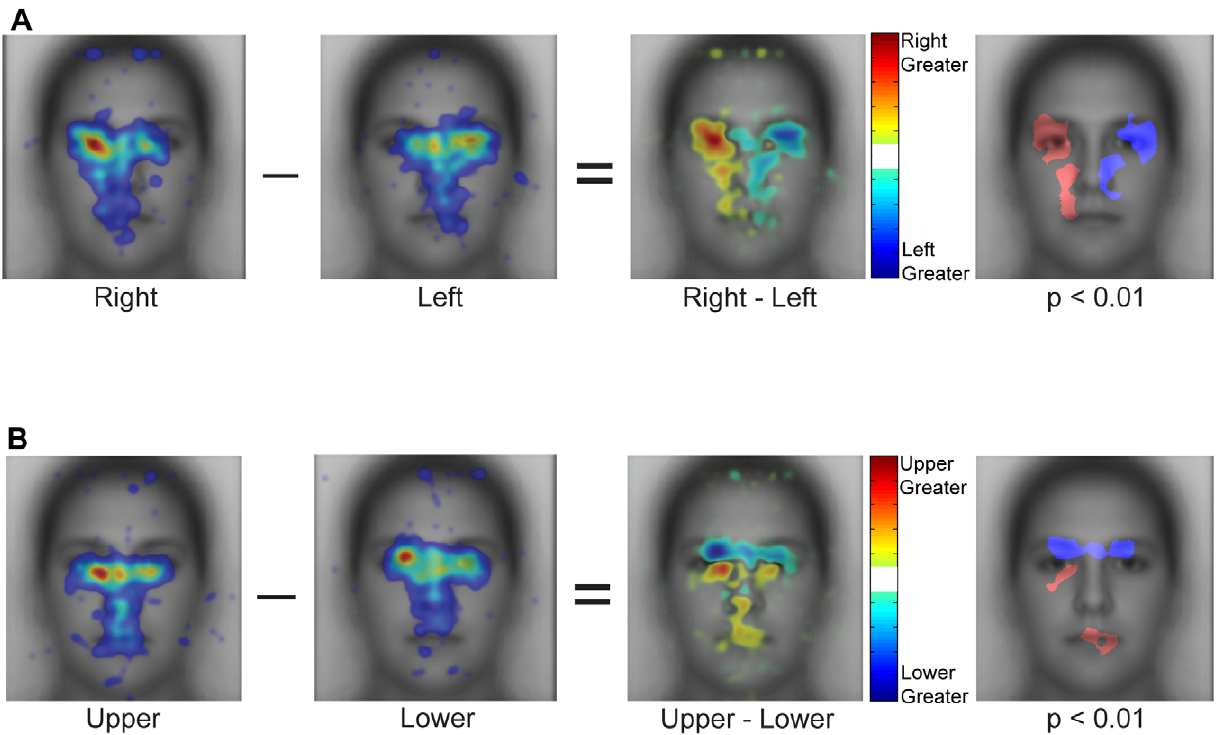
Figure 7. Direct comparison of spatial distributions of fixations for different start positions on upright faces. ( a ) Right vs. left start position. The first two panels are the raw spatial density maps for fixations 2–5. The third panel shows the subtraction of these spatial density maps. The fourth panel plots those locations where that difference was significant (p , 0.01) according to a Monte Carlo permutation test, which assumed exchangeability of fixations across contrasted start positions for each ordinal fixation. The map was cluster corrected (cluster threshold p , 0.05, see methods). Note the significant advantage for the side of the face opposite the start position. ( b ) Same as (a) but for the upper and lower start positions. Note again the strong and significant advantage for the side of the face opposite the start position. Fixation density in the raw heatmaps is indicated using a colorscale from zero to the maximum density value observed across the heatmaps for start position, with zero being transparent. The difference in fixation density in contrast heatmaps is indicated using a colorscale from plus to minus the largest absolute difference observed across start position contrast maps.